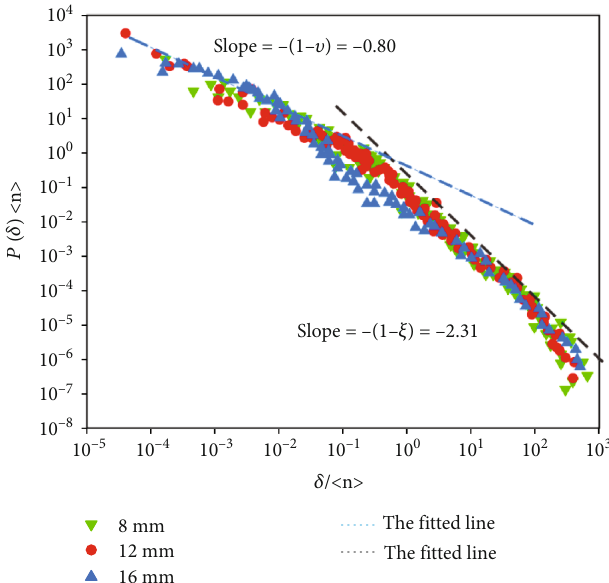
Figure 9: Distribution of waiting time of specimens with di ff erent borehole diameters.